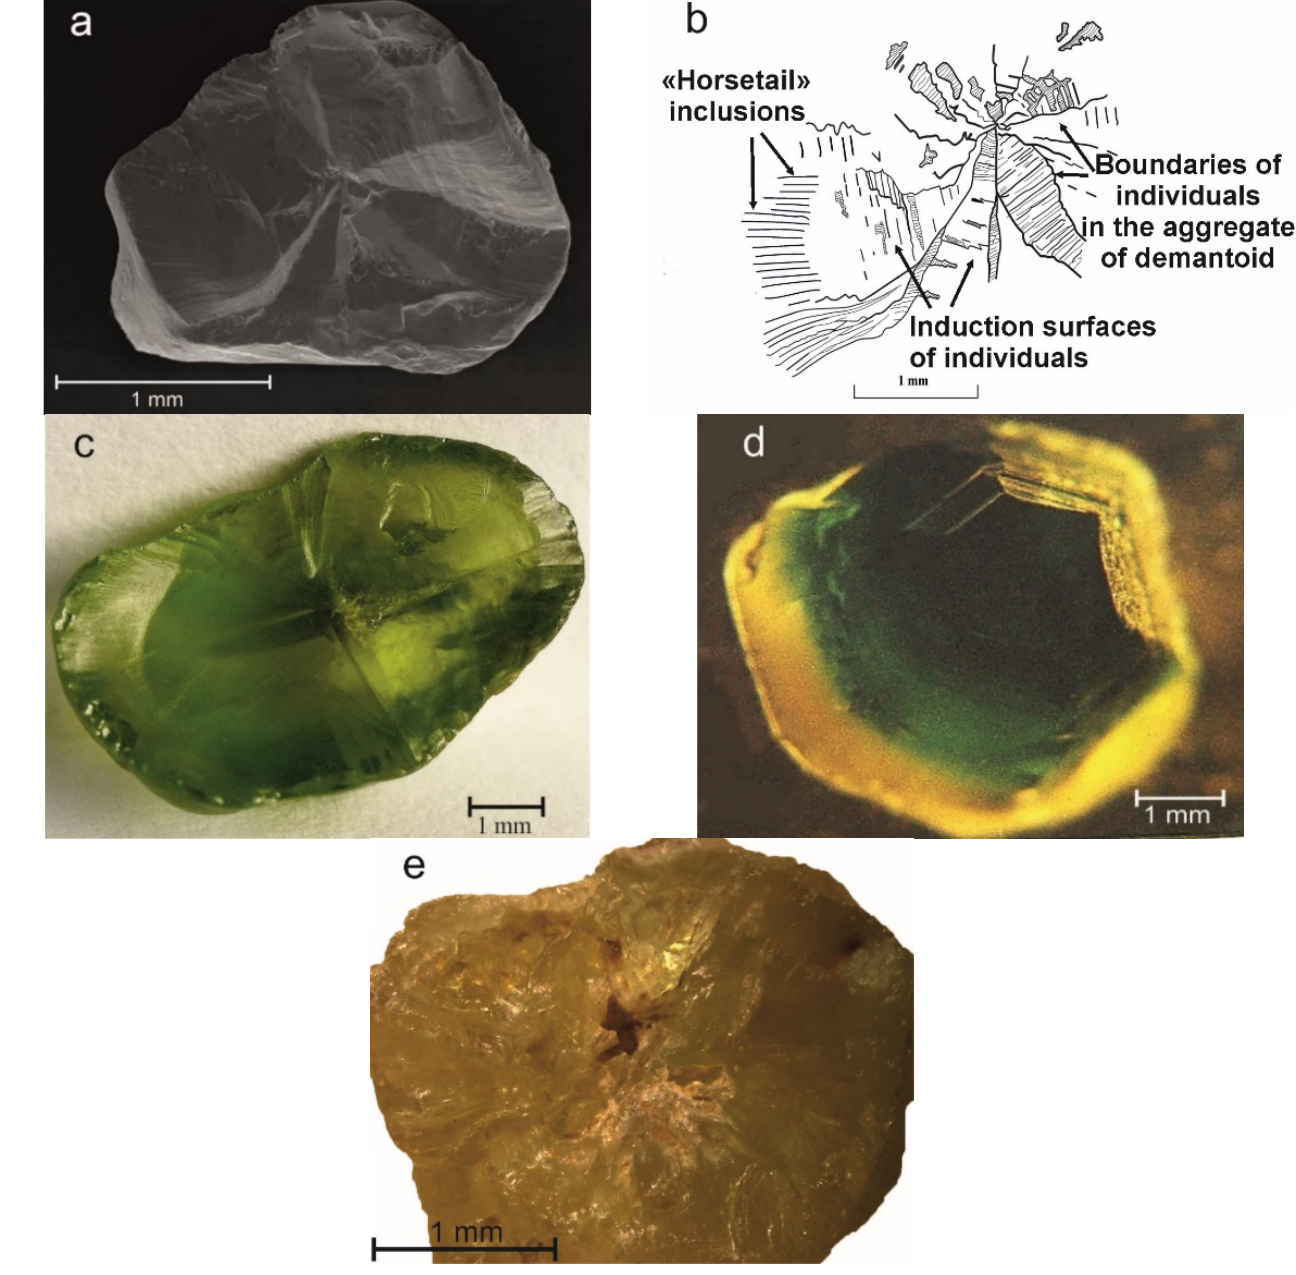
Figure 8. Features of the structure of the Ural demantoid grains: ( a ) photo of chipping through the central part of the demantoid grain, showing induction surfaces; ( b ) same, sketch from photo ( a ); ( c ) chipping through the central part of the demantoid grain (induction surfaces); ( d ) induction surfaces on the polychrome demantoid grain recovered from the aggregate; and ( e ) cavity in the central part of the demantoid grain.